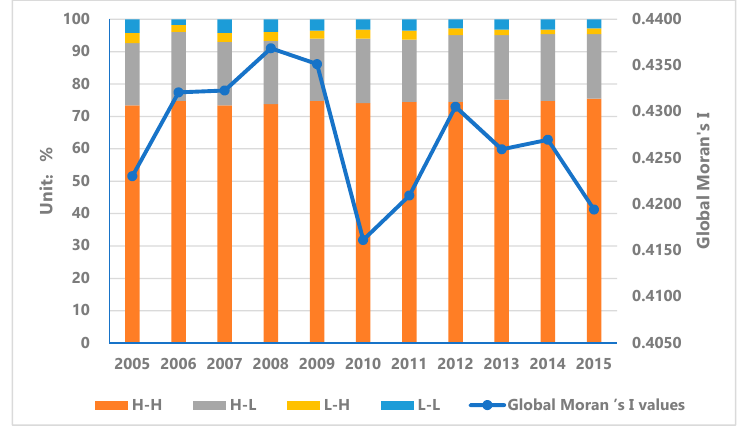
Figure 4. Global Moran’s I values of urbanization coordination level of sample cities in China from 2005 to 2015.